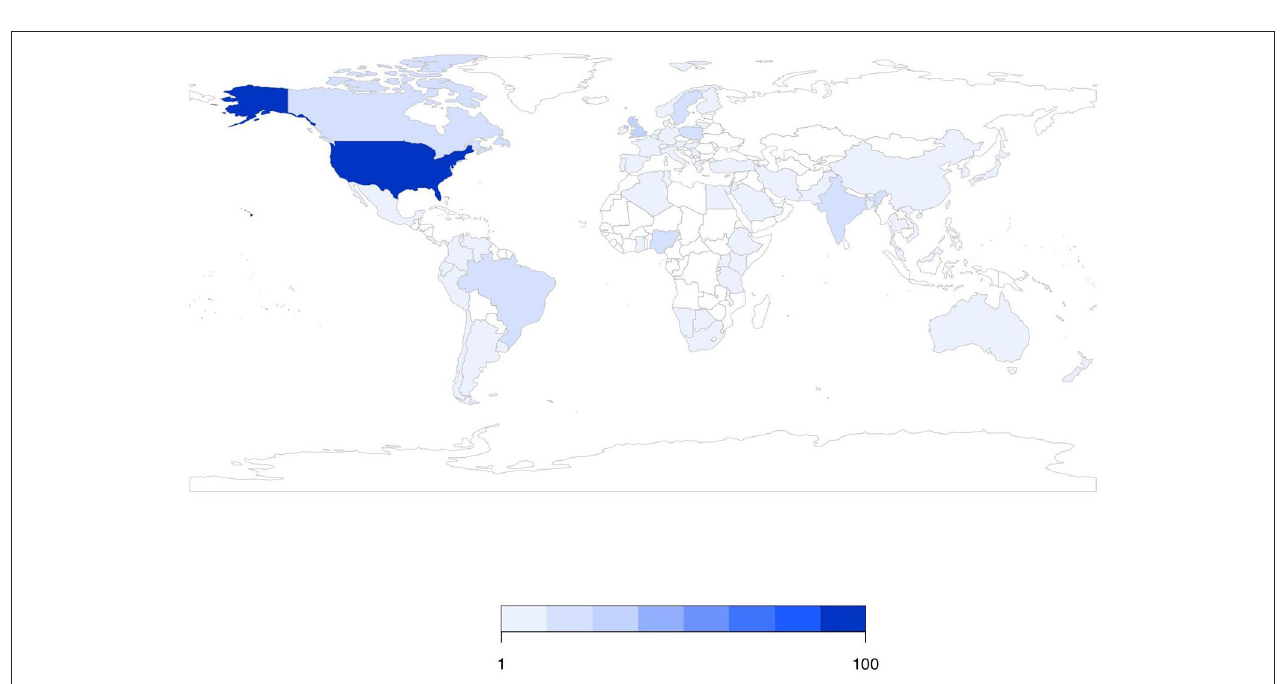
FIGURE 3 | Geographic distribution of 429 studies investigating Salmonella in animal feeds that reported the country where the study was conducted.